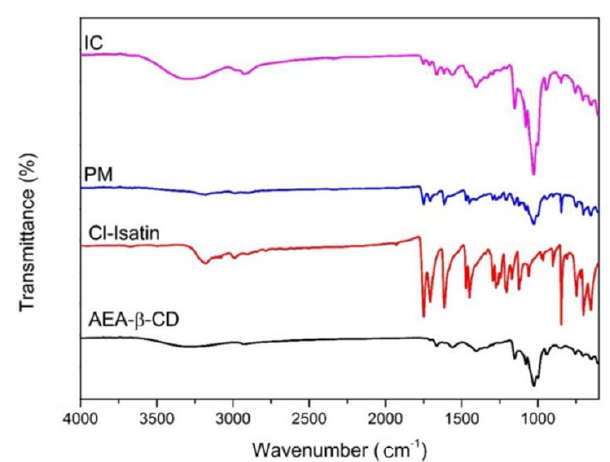
Figure 4. FT-IR spectra of AEA–β–CD, 5-chloroisatin (Cl-Isatin), and the 5-chloroisatin/AEA-β-CD physical mixture (PM), and the 5-chloroisatin/AEA–β–CD inclusion complex (IC).